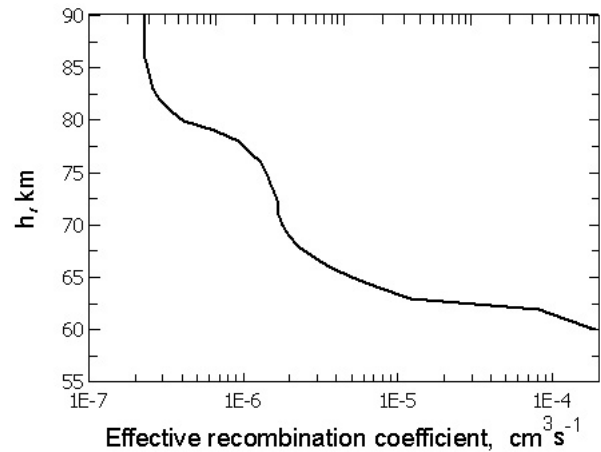
Fig. 10. Profiles of the effective recombination coefficient based on O-profiles 4 for 17 January 2005 at 09:50UT.